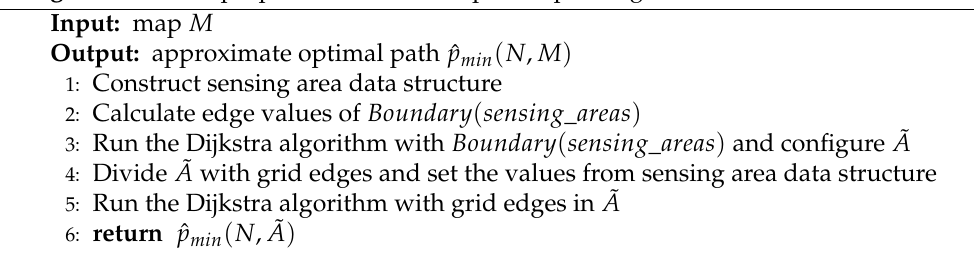
Algorithm 3: The proposed minimum exposure path